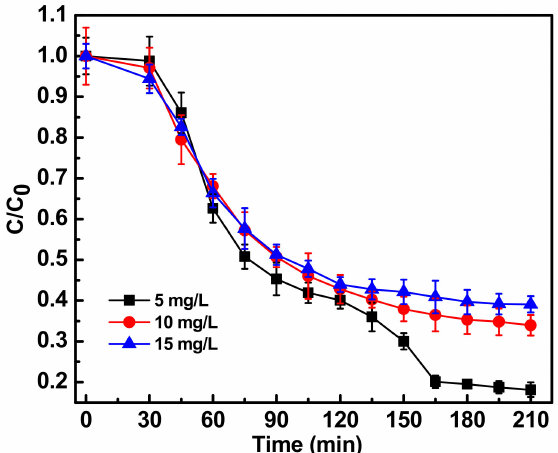
Figure 3. Photocatalytic degradation of antibiotic ciprofloxacin in water at different antibiotic concentration between 5, 10, 15 mg/L with optimum Fe-doped ZnO nanoparticles concentration of 150 mg/L and irradiated with sunlight intensity of 80,000 ± 3000 lux. C 0 represents initial concentration of ciprofloxacin and C represents concentration of ciprofloxacin at a particular time point. C/C 0 denotes, time dependent change in ciprofloxacin concentration with respect to initial